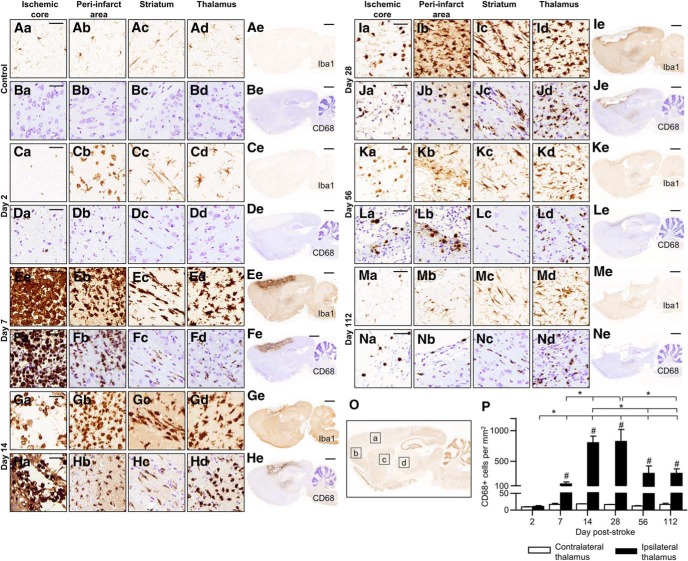
Time course of microglia/macrophage activation after cortical stroke. Representative images of immunostaining for all microglia/macrophages (Iba1) and phagocytic microglia/macrophages (CD68) from ischemic core (a), peri-infarct area (b), striatum (c), thalamus (d), and whole brain (e) sagittal sections at 2 (C, D), 7 (E, F), 14 (G, H), 28 (I, J), 56 (K, L), and 112 (M, N) days after 90-min dMCAO in rat. Control images (A, B) are from the contralateral hemisphere of the stroke brain. Scale bar is 50 µm (high magnification) and 2000 µm (low magnification). O, Example image of anti-NeuN immunostaining at post-stroke day 2 showing in more detail the regions a–d. P, Quantitation of CD68+ cells in the thalamus (d) at different time points showing the accumulation and clearance of phagocytic microglia/macrophages in the ipsilateral thalamus. *, p < 0.05 indicates statistical difference between the ipsilateral thalamus at different time points; #, p < 0.05 indicates statistical difference between the ipsilateral and contralateral thalamus in each time point, Mann–Whitney U test after Kruskal–Wallis test; n = 4 in each group. The data represent mean ± SEM.